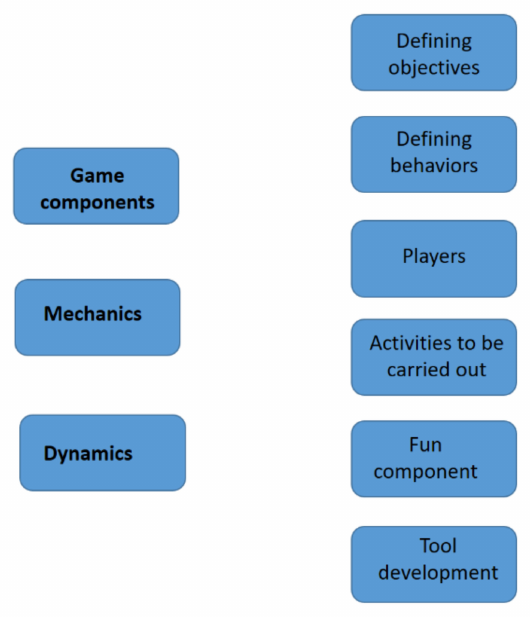
Figure 1. Steps to follow for the start-up